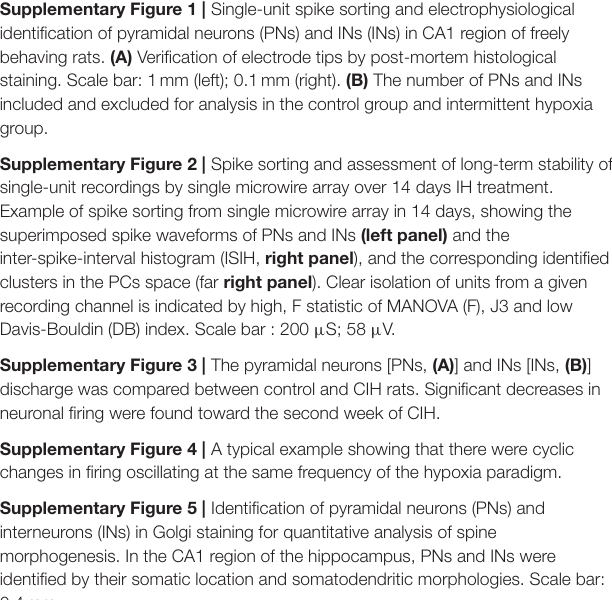
Supplementary Figure 1 | Single-unit spike sorting and electrophysiological identification of pyramidal neurons (PNs) and INs (INs) in CA1 region of freely behaving rats. (A) Verification of electrode tips by post-mortem histological staining. Scale bar: 1mm (left); 0.1mm (right). (B) The number of PNs and INs included and excluded for analysis in the control group and intermittent hypoxia group. Supplementary Figure 2 | Spike sorting and assessment of long-term stability of single-unit recordings by single microwire array over 14 days IH treatment. Example of spike sorting from single microwire array in 14 days, showing the superimposed spike waveforms of PNs and INs (left panel) and the inter-spike-interval histogram (ISIH, right panel ), and the corresponding identified clusters in the PCs space (far right panel ). Clear isolation of units from a given recording channel is indicated by high, F statistic of MANOVA (F), J3 and low Davis-Bouldin (DB) index. Scale bar : 200 µ S; 58 µ V. Supplementary Figure 3 | The pyramidal neurons [PNs, (A) ] and INs [INs, (B) ] discharge was compared between control and CIH rats. Significant decreases in neuronal firing were found toward the second week of CIH. Supplementary Figure 4 | A typical example showing that there were cyclic changes in firing oscillating at the same frequency of the hypoxia paradigm. Supplementary Figure 5 | Identification of pyramidal neurons (PNs) and interneurons (INs) in Golgi staining for quantitative analysis of spine morphogenesis. In the CA1 region of the hippocampus, PNs and INs were identified by their somatic location and somatodendritic morphologies. Scale bar: